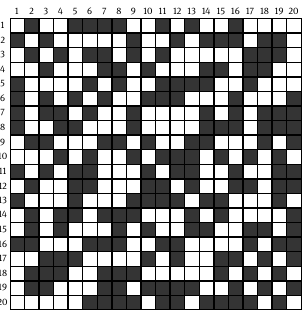
Figure 3.3: The adjacency matrix plot of graph F with a (8, 10) -regular set of Example 3.3.